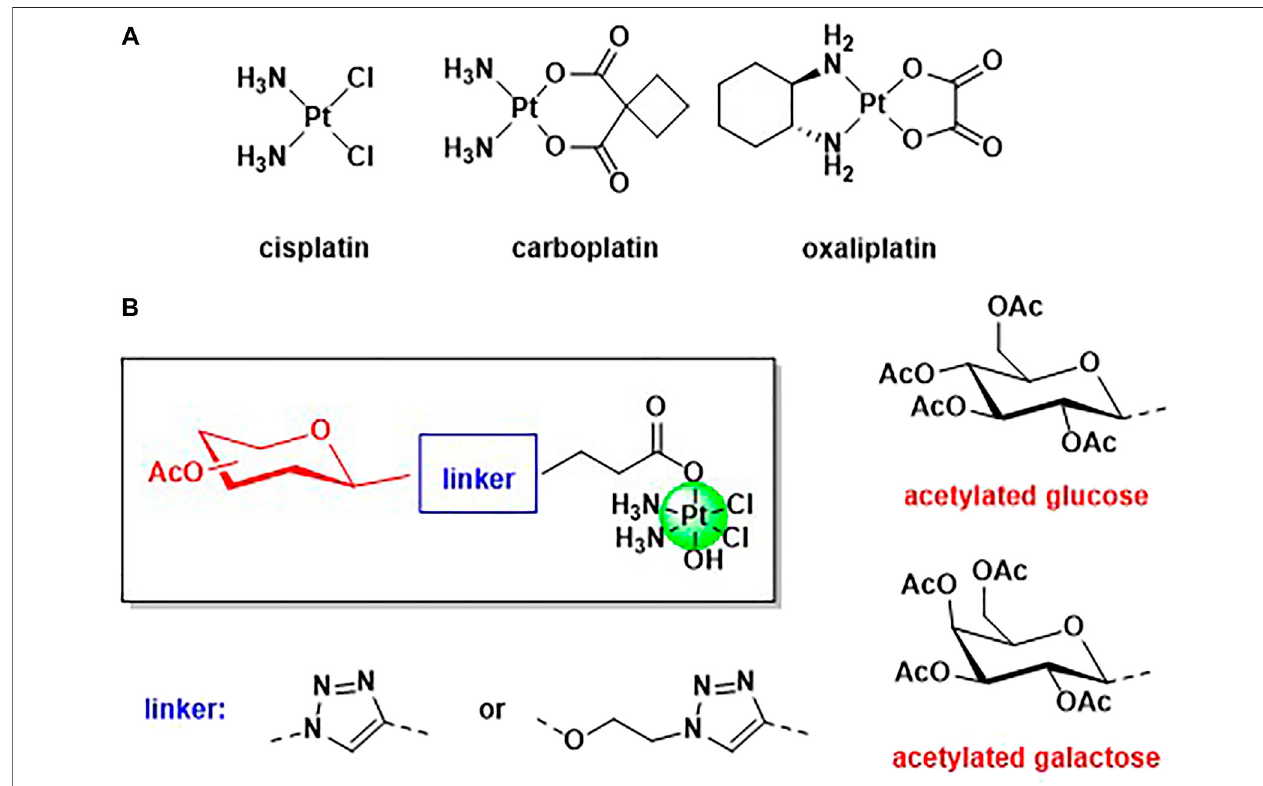
FIGURE 1 | (A) Structure of the three worldwide approved Pt(II) based anticancer drugs, cisplatin, carboplatin, and oxalilplatin. (B) General structure of the novel Pt(IV) complexes based on cisplatin scaffold and functionalised with acetylated glucose and galactose.